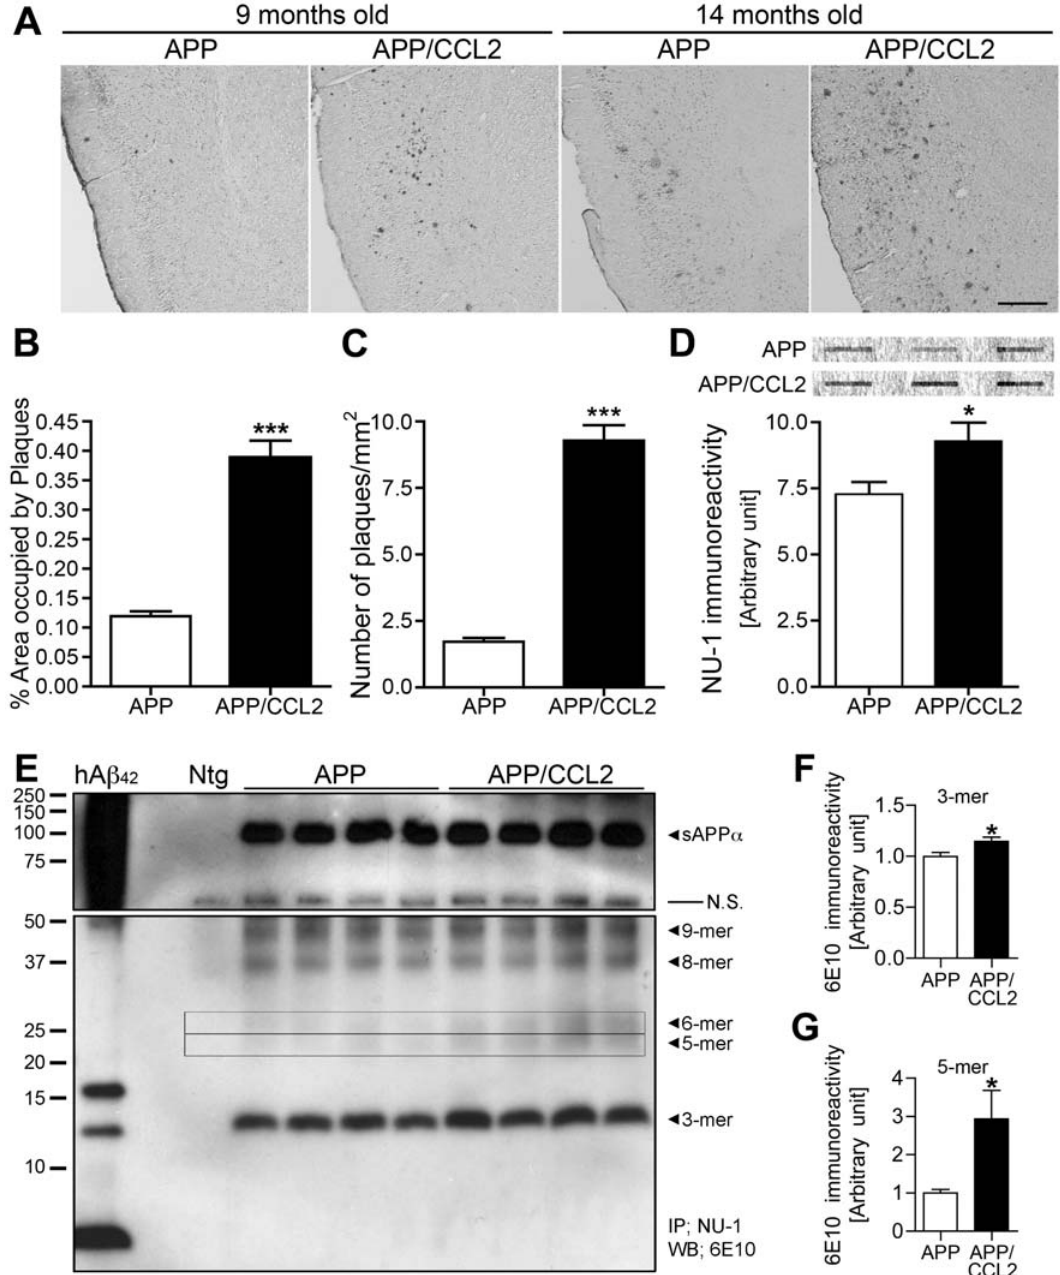
Figure 3. Enhanced A b oligomer formation and deposition in APP/CCL2 mice. (A) Frozen sections (10- m m thickness) of temporal cortex of APP and APP/CCL2 mice at 9 and 14 months of age were immunostained by A b antibody and visualized by DAB staining. Scale bar, 400 m m. (B and C) Quantification of cortical A b staining in APP and APP/CCL2 mice at 9 months of age (n=5 per group). Percent area occupied by immunoreactivity (C) and numbers of plaques were measured. *** denotes p , 0.001 vs APP/CCL2 as determined by Student’s t -test. (D) APP/CCL2 and APP mice were sacrificed at 9 months of age and 2% SDS-soluble fractions were subjected to dot blot assay for A b oligomer using NU-1 as described (each brain sample per dot). Top panel is a representative dot blot image (3 representative dots per group out of n=6 per group). Bottom panel shows quantification of band luminescent intensities (n=6 per group). * denotes p , 0.05 vs APP/CCL2 as determined by Student’s t -test. (E–G) Identification of A b oligomers in the brains of APP and APP/CCL2 mice assessed by immunoprecipitation of A b oligomers from extracellular-enriched fraction using NU-1 anti-A b oligomer monoclonal antibody and Western blot using biotinylated 6E10 anti-A b monoclonal antibody. Oligomerized synthetic human A b 1–42 peptide was used as a size marker and positive control of A b oligomers (hA b 42, left lane). Arrows indicate respective migration positions of trimers (3-mer), pentamer (5-mer in box), hexamers (6-mer in box), octamer (8-mer), and nonamers (9-mer). Band luminescent intensities for trimers (F) and pentamers (G) were quantified by Image J software. * or *** denotes p , 0.05 or 0.001 as determined by Student’s t -test, respectively.